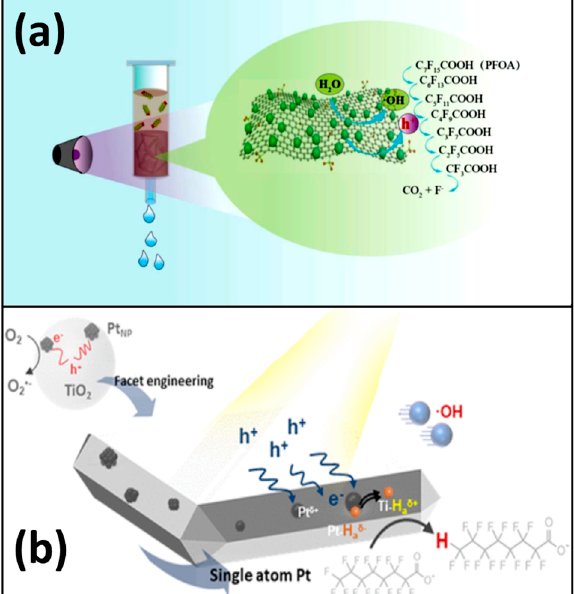
Figure 2. PFOA degradation using ( a ) TiO 2 quantum dots supported on sulfonated graphene nanosheets (reprinted from [64], copyright (2020) with permission from Elsevier) and ( b ) single Pt atoms loaded on the reductive sites of the TiO 2 facet (reprinted from [67], copyright (2021) with permission from ACS Publications).